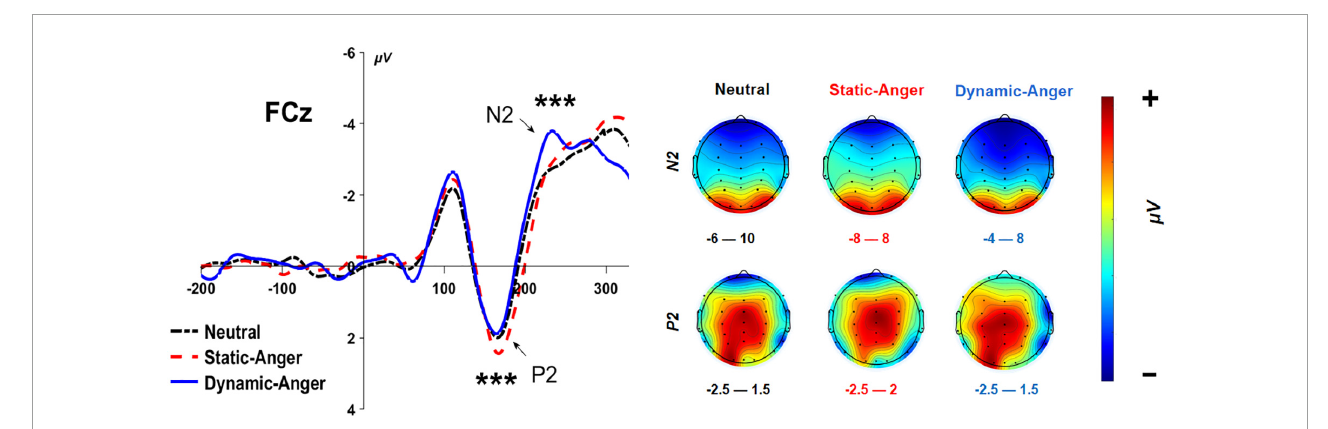
FIGURE4 The grand-mean ERP waveforms of the N2 and P2 components at FCz. *** P < 0.001.